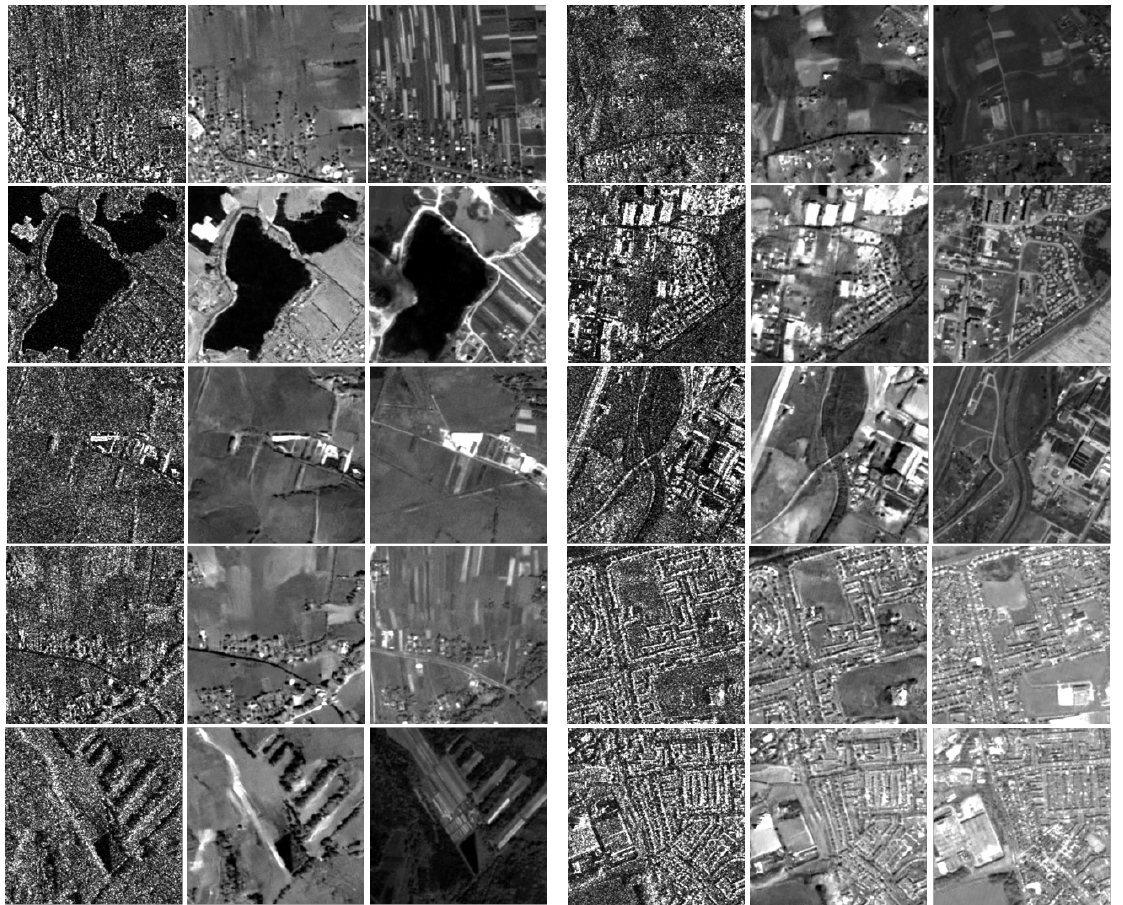
Figure 3. Results obtained from the applied network, organized in two blocks. Left : original SAR file, center: images generated with adapted CycleGAN, right : optical